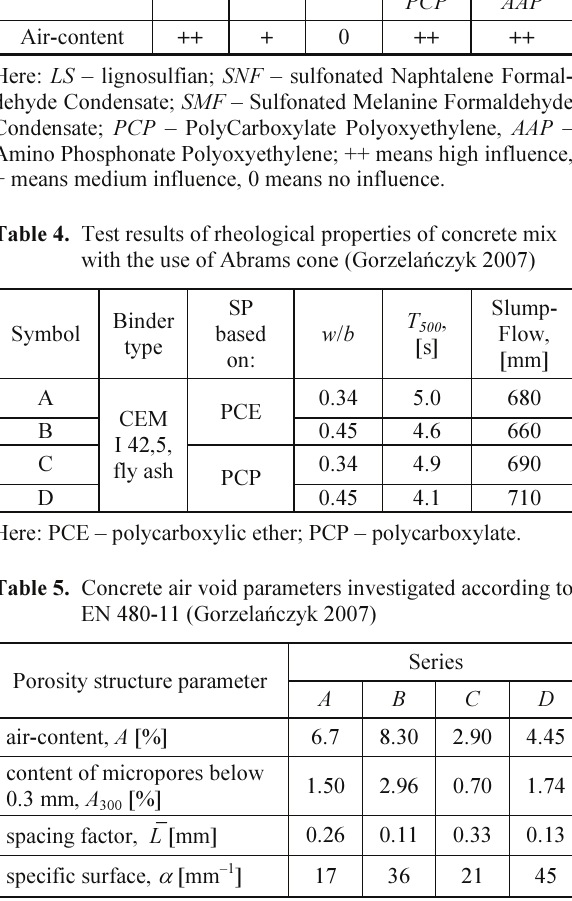
Table 3. The influence of a superplasticiser on mix air- entrainment (Mosquet 2003) SP type